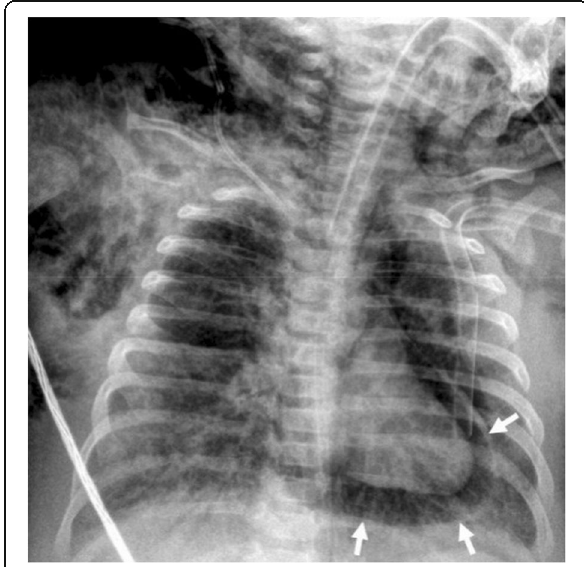
Fig. 3 A 3-month-old girl with pneumonia and sepsis developed pneumopericardium (arrows) under endotracheal intubation at insensitive care